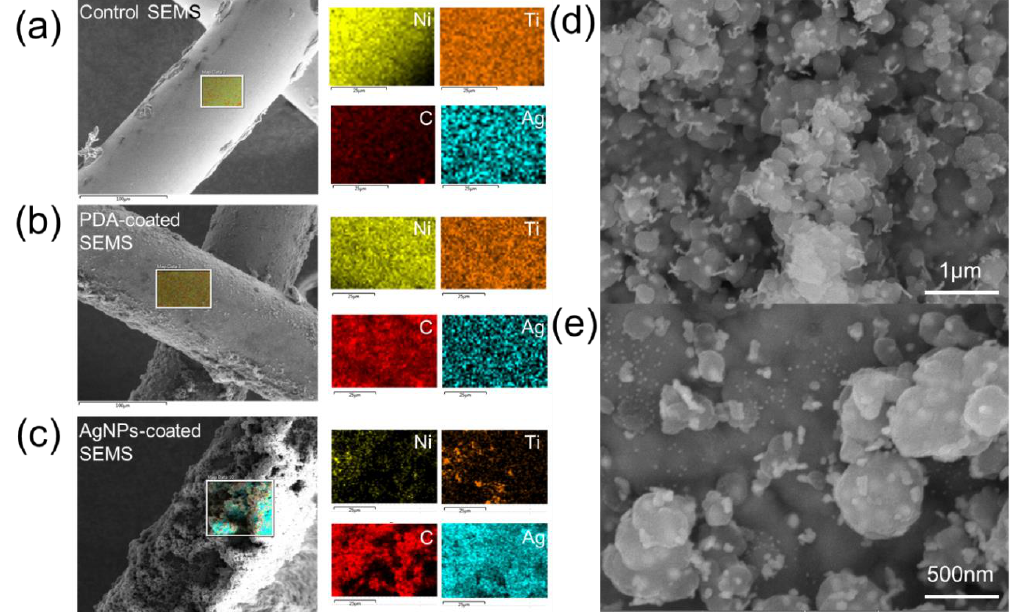
Figure 1. Characterization of an Ag nanoparticle (AgNP)-coated self-expandable metallic stent (SEMS). Scanning electron microscopy (SEM) with energy-dispersive X-ray spectroscopy (EDS) mapping analysis of ( a ) control SEMS, ( b ) polydopamine (PDA)-coated SEMS, and ( c ) AgNP-coated SEMS (yellow, orange, red, and blue indicate nickel, titanium, carbon, and silver, respectively). ( d , e ) High-magnification SEM image of the surface of an AgNP-coated SEMS. Note: PDA, polydopamine; SEMS, self-expandable metallic stent; AgNP, Ag nanoparticle.